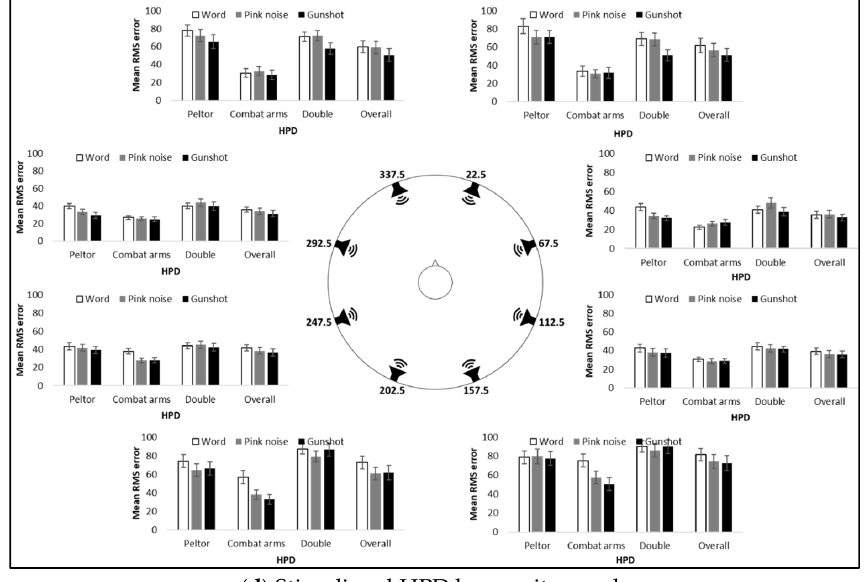
( d ) Stimuli and HPD by monitor angle Figure 5. Mean RMSE of stimuli for ( a ) stimuli only (no-HPD condition), averaged across all 90 participants; ( b ) stimuli only (no-HPD condition) at each source angle, averaged across all 90 participants, including statistics for main effect for stimuli at each source angle; ( c ) stimuli only (HPD condition), averaged across HPDs for all 90 participants; and ( d ) stimuli and HPD at each source angle, averaged across 30 participants in each HPD group. * p < 0.05. Table 1. Results of Least-Significant-Difference (LSD) test for post hoc comparisons between the mean RMSE for monitors in different angles in the (a) non-HPD condition and (b) HPD condition (monitor angles correspond to Figure 1).